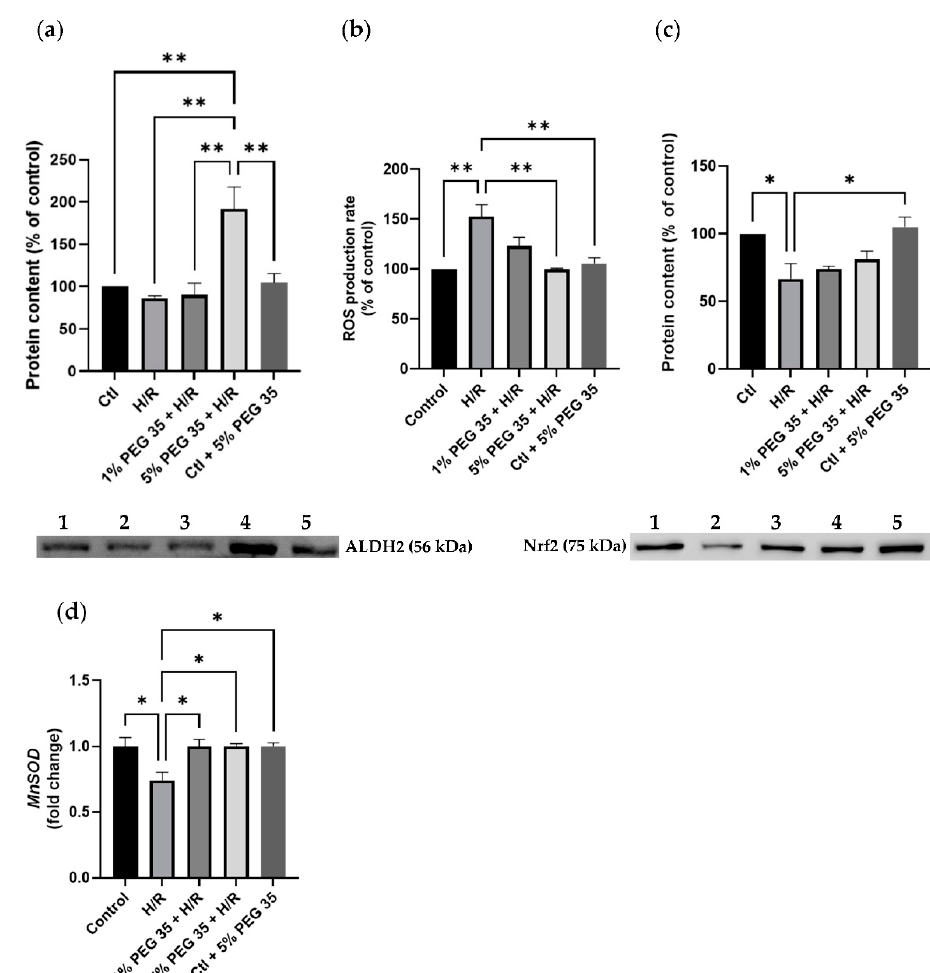
Figure 2. Effects of PEG 35 in mitochondrial ALDH2 levels and oxidative stress in HepG2 submitted to H/R. ( a ) Representative Western blot for ALDH2 and respective quantification for: 1-Ctl; 2-H/R; 3–1% PEG35 + H/R; 4–5% PEG35 + H/R; 5-Ctl + 5% PEG35. ( b ) ROS production rate measured fluorometrically as described in the Materials and Methods section. ( c ) Representative Western blot for Nrf2 and respective quantification for: 1-Ctl; 2-H/R; 3–1% PEG35 + H/R; 4–5% PEG35 + H/R; 5-Ctl + 5% PEG35. ( d ) Gene expression for MnSOD. The values shown represent the mean ± SEM of 3 independent experiments. * p < 0.05; ** p < 0.01;